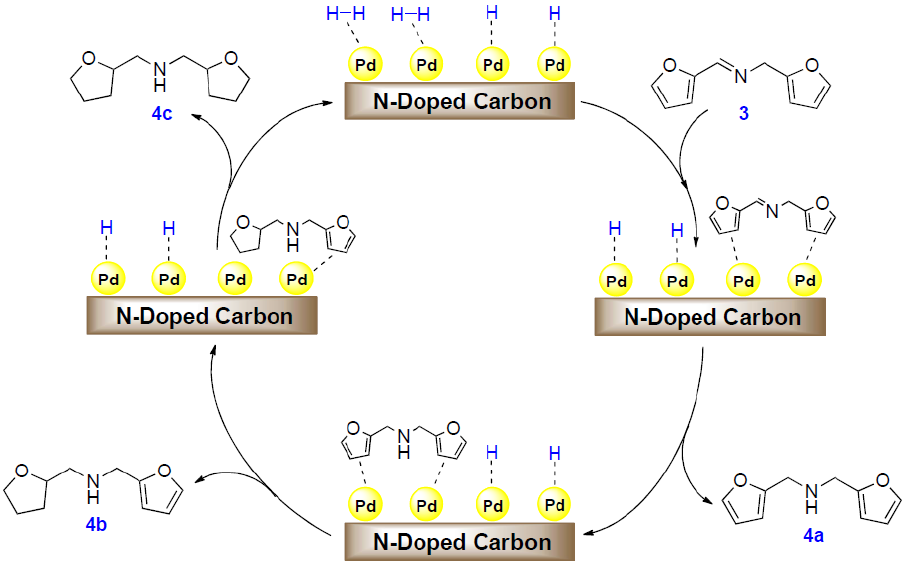
Figure 10. Proposed reaction pathway for the reductive amination of furfural with furfuryl amine over Pd-N/Ca system.